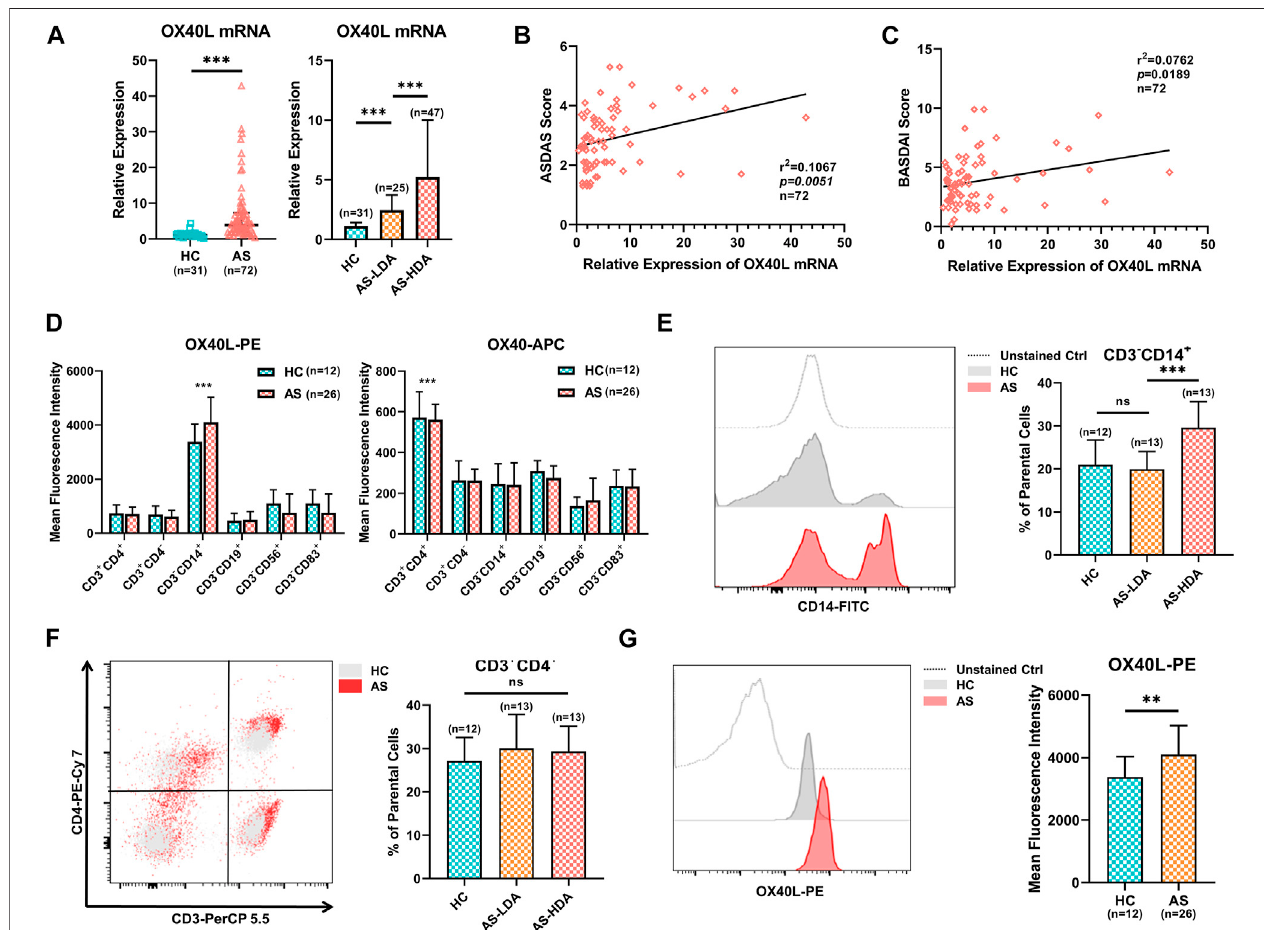
FIGURE 5 | Expression pro fi les of OX40L in PBMCs of AS patients. (A) Quantitative real-time PCR (qRT-PCR) analysis of OX40L mRNA in PBMCs of 72 AS patients with different disease activities and 31 healthy controls. (B,C) Correlation analysis for OX40L in PBMCs with the ASDAS and BASDAI score of AS patients (n (cid:2) 72). (D). OX40L and its receptor, OX40, were tested in PBMCs of AS patients (n (cid:2) 26) and healthy controls (n (cid:2) 12) by fl ow cytometry. Mean fl uorescence intensity (MFI) wasusedtoanalyzedifferentiallyexpressedOX40/OX40LoncellsmarkedbyCD3 + CD4 + ,CD3 + CD4 − ,CD3 − CD14 + ,CD3 − CD19 + ,CD3 − CD56 + ,andCD3 − CD83 + . (E,F) Cell ratios of CD3 − CD14 + cells and CD3 + CD4 + T cells in PBMCs of AS patients (n (cid:2) 26) and healthy controls (n (cid:2) 12) were detected by fl ow cytometry; (G) represented illustration and MFI of OX40L on the CD3 − CD14 + cell group of PBMCs from AS patients and healthy controls followed by fl ow cytometry. Data in A are presented as median ± quartile, and data in other chart plots are presented as mean ± SD. ns: p ≥ 0.05; ** p < 0.01; *** p < 0.001.